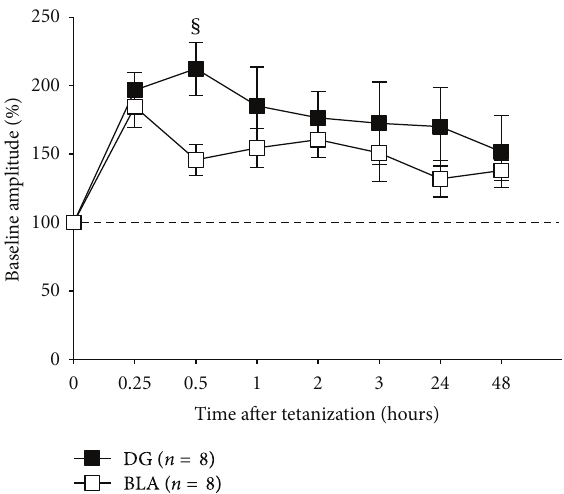
F 3: eta burst stimulation of the perforant path results in LTP recorded concurrently in BLA and DG. Analysis of variance revealed no signi�cant difference between DG-LTP and BLA-LTP at ). Each point represents the average any of the time points ( of 5 responses to single-pulse stimulation recorded in each animal x (stimulation frequency = 𝑃𝑃 𝑃 𝑃𝑃𝑃𝑃